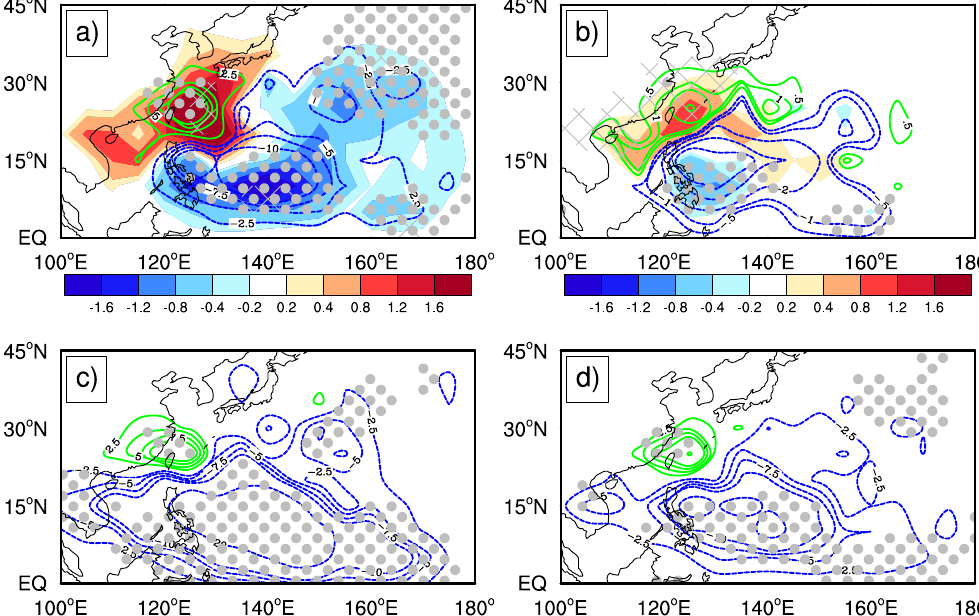
Figure 1. Trends and composite differences in the observed ITCTs. ( a ) Trends in ITCTs (shades; counts per decade) during 1980–2015 and composite differences in the observed ITCTs between the hiatus (1998–2015) and pre-hiatus (1980–1997) periods (contour; counts per decade); ( b ) same as ( a ) but calculated for the points where TCs reached ITC only (with the SMWS larger than 96 knots); ( c ) composite differences in ITCTs between the hiatus (1998–2009) and pre-hiatus (1982–1997) periods using the ADT-HURSAT data; and ( d ) same as ( c ) but using the JTWC TC best-track data. Areas where composite differences are statistically significant above the 90% confidence level are shown in grey dots based on the Mann-Whitney U test. The slashes in ( a ) and ( b ) represent areas where the trend is statistically significant above the 90% confidence level based on Student’s t test. This figure was generated by the NCAR Command Language (Version 6.4.0) [Software]. (2017). Boulder, Colorado: